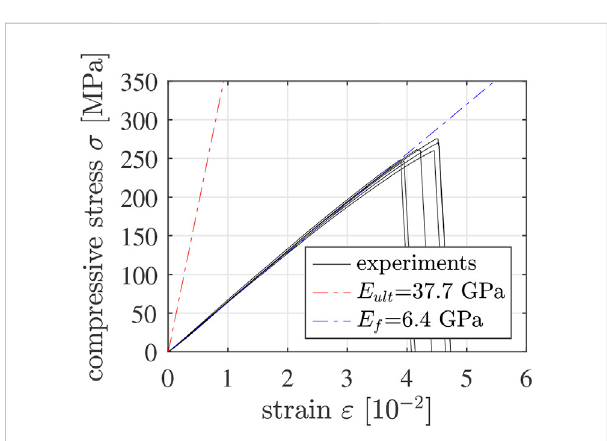
FIGURE 14 Stress-strain diagrams of the most mature 5/10 specimens: the pre-peakpathshaveaslopeamountingto6.4 GPa,seethebluedash- dotted line; the slope of the red dash-dotted line corresponds to actual modulus of elasticity of mature Biodentine, obtained from ultrasonic pulse velocity measurements. Note that in case of the mechanical experiments, “ strain ” refers to the sum of the absolute values of the compressive axial strain undergone by thespecimen and the tensile axial strain undergone by the testing